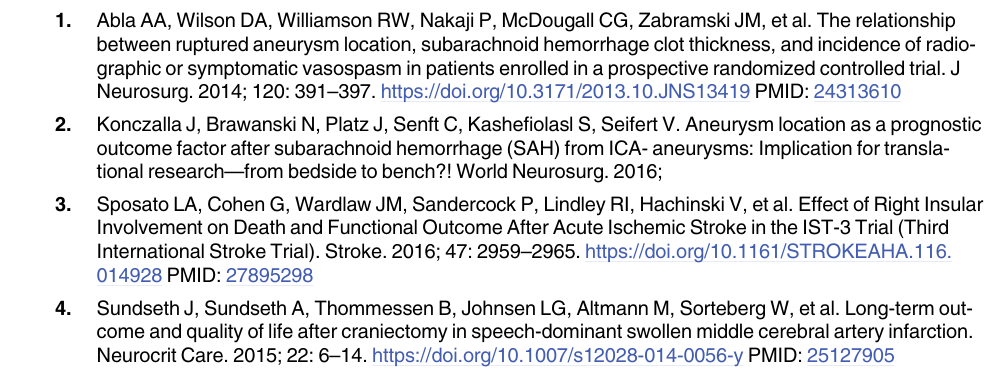
S1 Table. Prognostic factors in right- and left-sided aneurysms and comparison of both patient